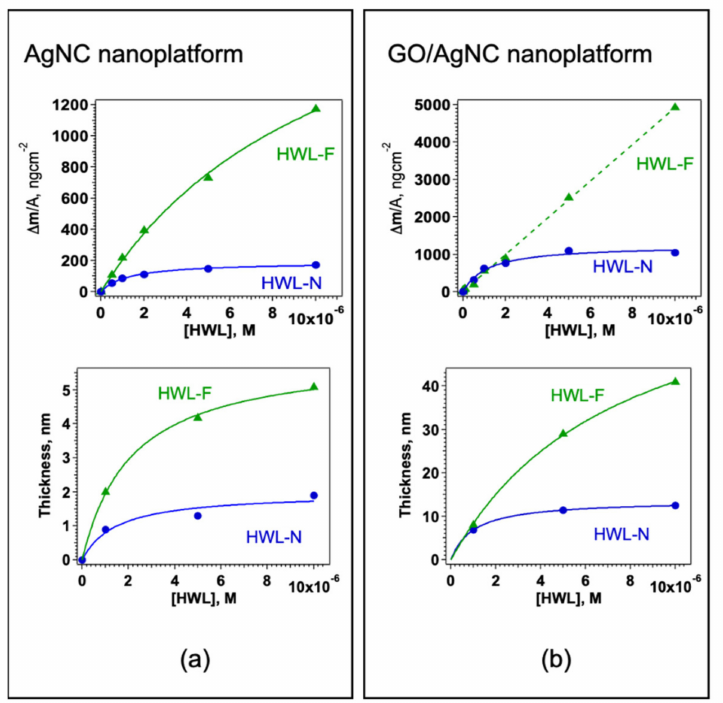
Figure 4. Surface density and thickness for HWL-N (green triangles) and HWL-F (blue circles) on ( a ) AgNC/NS and ( b ) GO-AgNC/NS